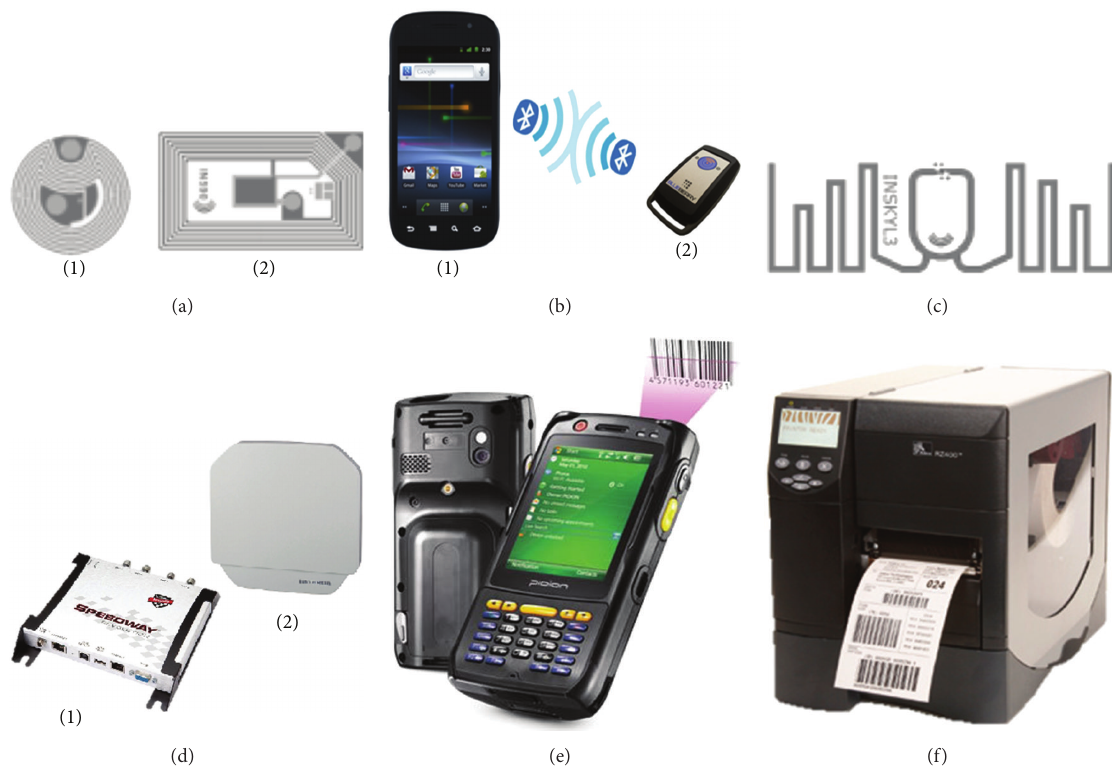
Figure 4: Main devices used in the pilot Project: (a) NFC tags: (1) Mifare Ultralight and (2) Mifare Classic; (b) portable NFC/RFID scanner composed of a (1) Samsung i9023 Nexus S and a (2) BlueBerry reader; (c) INSKYL3 passive UHF RFID tag; (d) RFID UHF gate composed of (1) Impinj Speedway Revolution R420 reader and (2) Wide Range UHF Kathrein antenna; (e) BIP-6000 of Meteor scanner; (f) Zebra RZ400